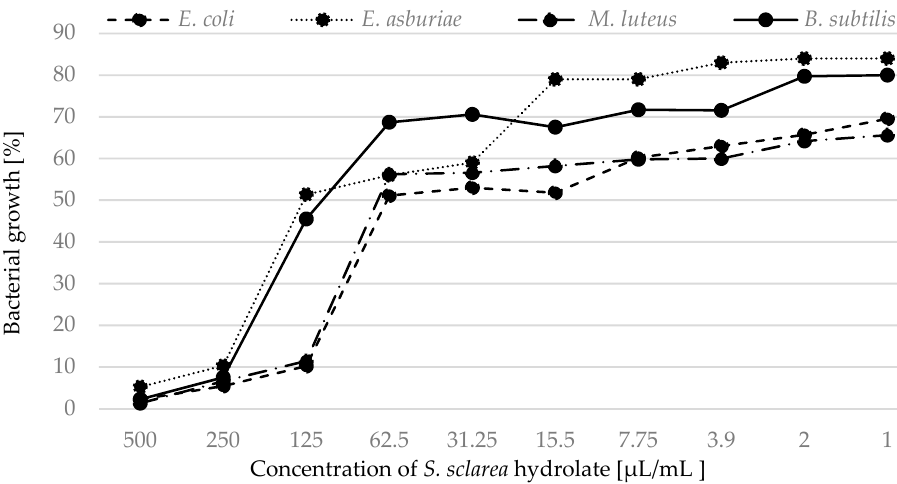
Figure 3. The growth of bacterial strains in the presence of S. sclarea hydrolate. The results showed that hydrolates of S. nemorosa inhibited more Gram-positive than Gram-negative bacterial strains (Figure 4).